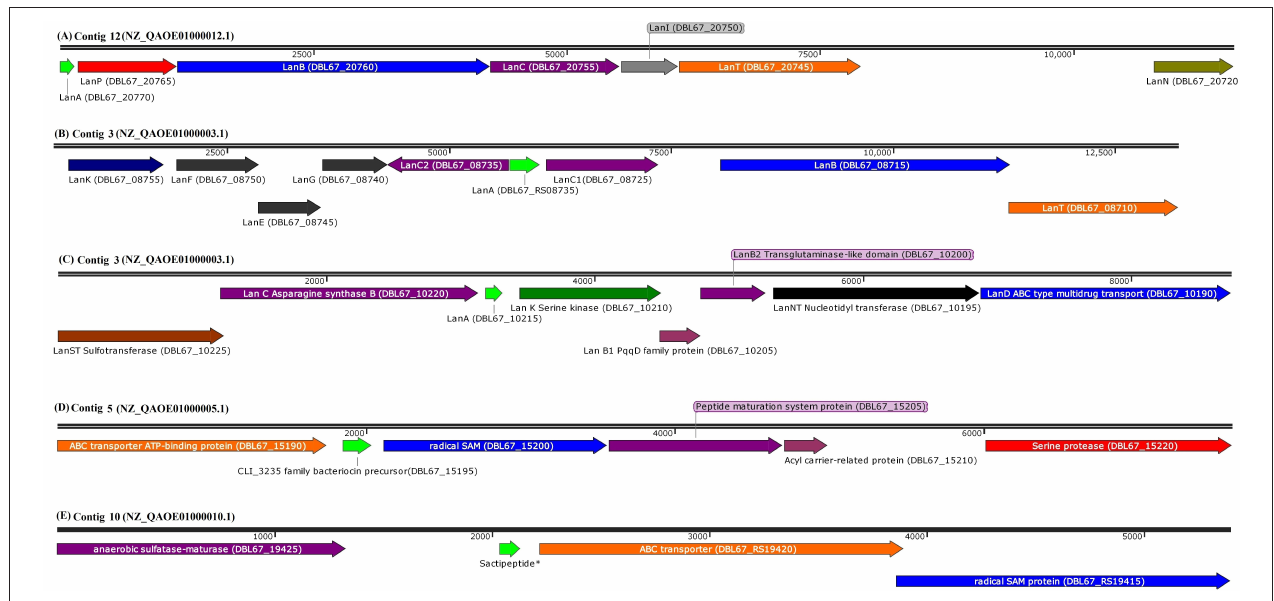
FIGURE 1 | Arrangement of genes encode for structural peptide and putative biosynthetic proteins in biosynthetic gene cluster of (A) paenibacillin (GenBank coordinates from 63008 to 75697 in complementary strand), (B) paenilan (GenBank coordinates from 26187 to 38676 in complementary strand), (C) paeninodin (GenBank coordinates from 328300 to 337092 in complementary strand), (D) CLI_3235 family bacteriocin precursor, predicted as sactipeptide ( sacti5 ) by BAGEL4 (Genbank coordinates from 183766 to 191369 in forward strand), and (E) sactipeptide* (GenBank coordinates from 68257 to 73648 in complementary strand) in respective contigs of P. polymyxa Kp10 genome. Sactipeptide* of the contig 10 ( sacti10 ) has failed to be annotated by NCBI Prokaryotic Genome Annotation Pipeline. BAGEL4 analysis annotates the open reading frame as sactipeptide. The contigs with their respective accessions and locus tags of each genes/coding sequences are included in the figure. Genes are shown to scale and coordinates are relative to the length of each